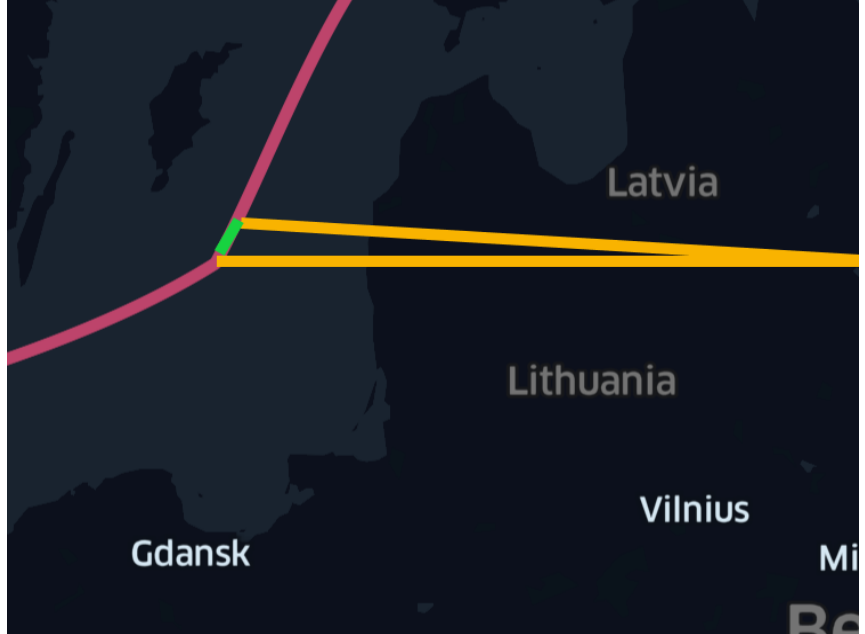
Figure 13. The proposed algorithm removes the noise point, and the green part indicates the other valid vessel trajectory part.